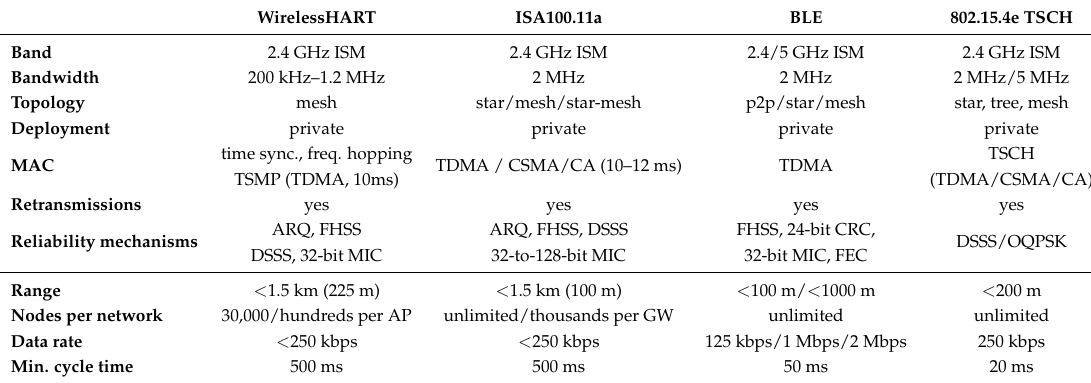
Table 3. Technical properties (top) and key performance indicators (bottom) of IIoT wireless technologies based on 802.15.4 2.4 GHz PHY layer and